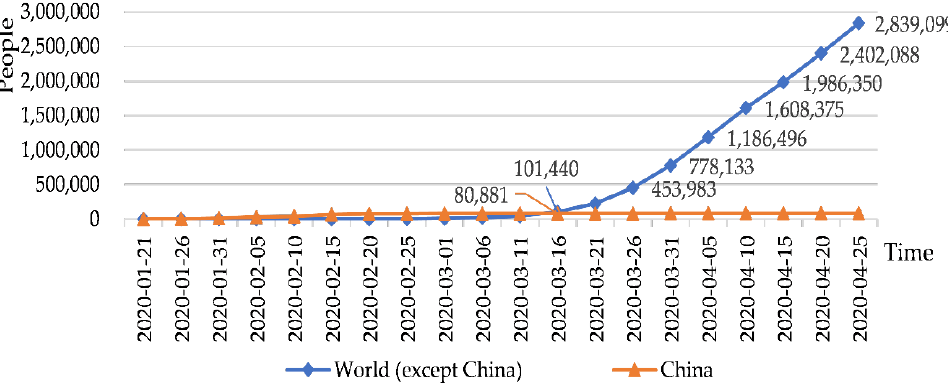
Figure 2. Confirmed cases of COVID-19 in world . Note 1. Data was collected from Wind database.